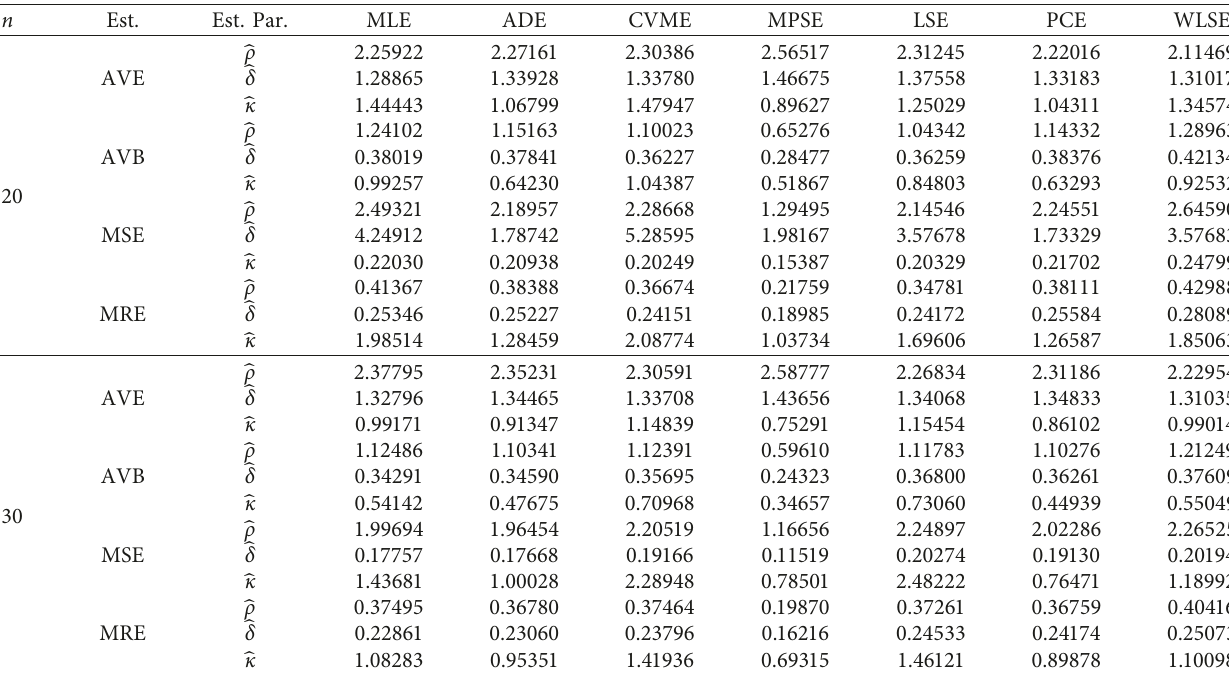
Table 8: Simulation results of the AVE, AVB, MSE, and MRE of BXLE distribution for ( ρ � 3 , δ � 1 . 5 , κ � 0 . 5 ) . n